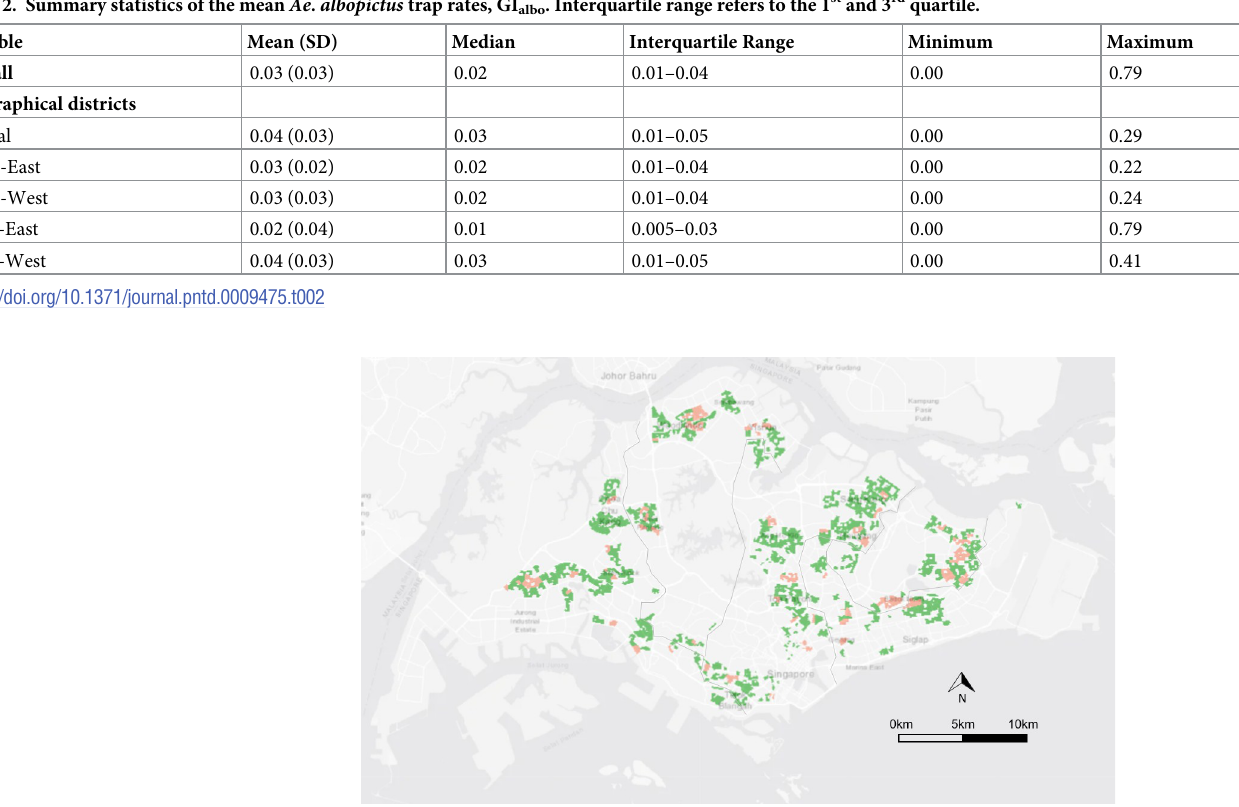
Fig 4. Map showing the spatial distribution of the cases (red) and controls (green). The grey boundary lines indicate the five geographical districts in Singapore. The figure was created using R software with base layer obtained from https://landsatlook.usgs.gov/ .